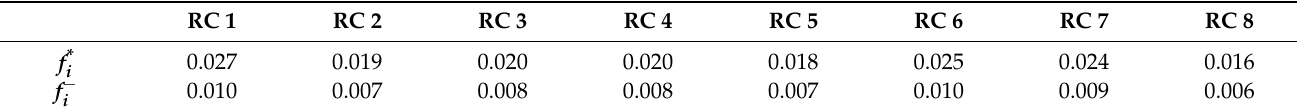
Table 9. Positive ideal solution and negative ideal solution of RCs.